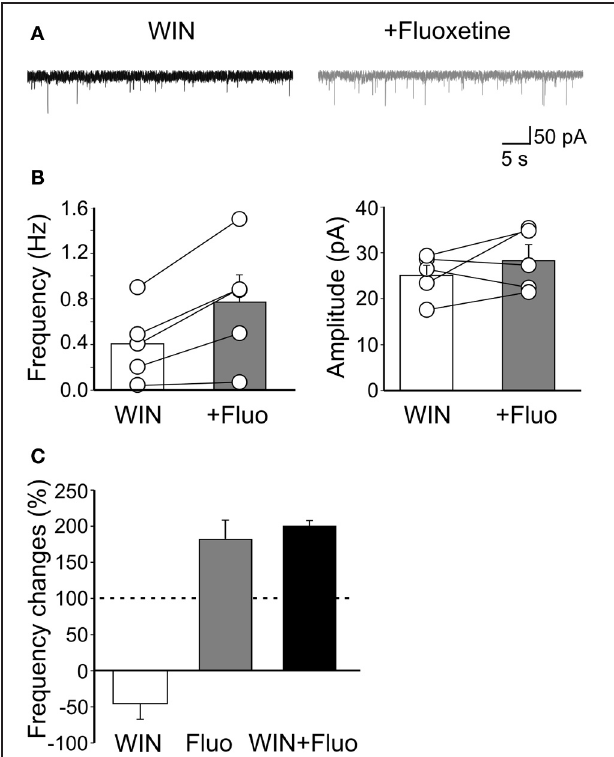
FIGURE 5 | Fluoxetine-induced increase of mGPSCs frequency does not involve CB1 receptor-positive GABAergic interneurons. (A) Sample traces of mGPSCs recorded in the presence of WIN55,212-2 (1 μ M) and WIN55,212-2 plus fluoxetine (20 μ M). (B) Summary plots of the mean frequency ( n = 5; p = 0 . 02) and amplitude ( n = 5; p = 0 . 3) of mGPSCs recorded in the presence of WIN55,212-2 (white columns) and WIN55,212-2 plus fluoxetine (gray columns) for all cells tested ( ± SEM). (C) Frequency changes (as percentage of controls) induced by bath application of WIN55,212-2 (white), fluoxetine (grey) and fluoxetine plus WIN55,212-2 (black). Note that while WIN55,212-2 depressed the frequency of mGPSCs fluoxetine increased it. In addition, a similar percentage increase of mGPSCs frequency occurred when fluoxetine was applied alone or in the presence of